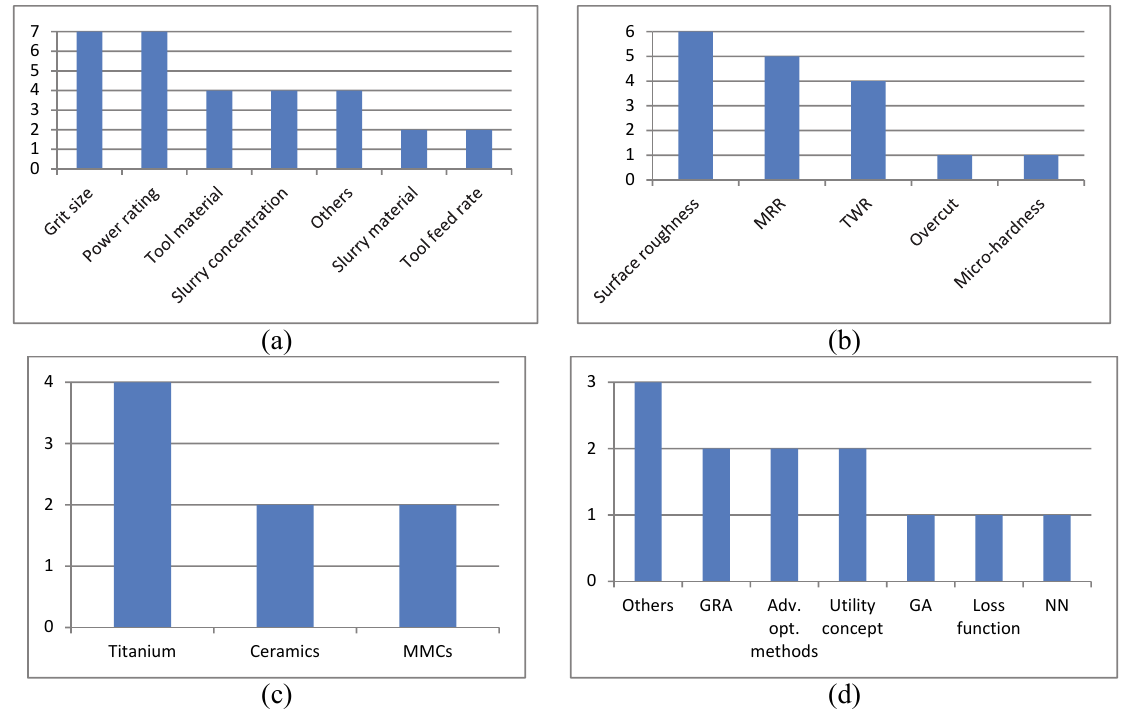
Fig. 5 Analysis on the parametric optimization of USM